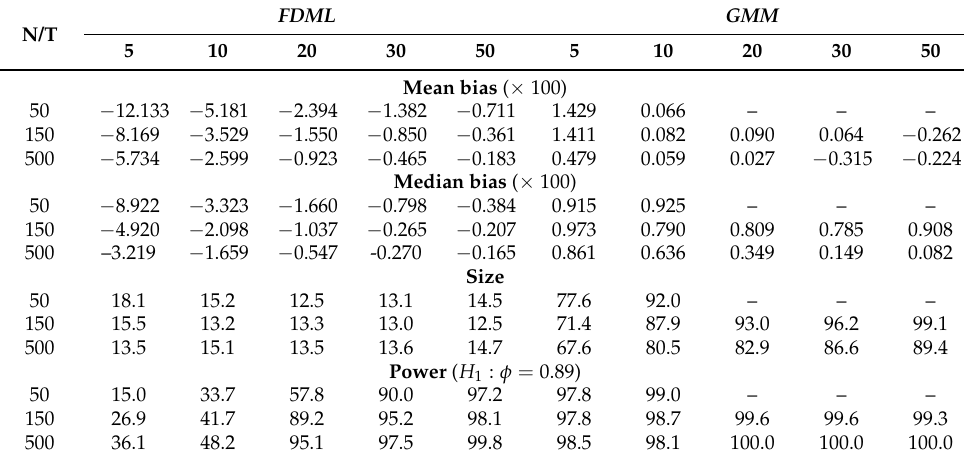
Table 3. Mean bias, median bias, size and power for φ =